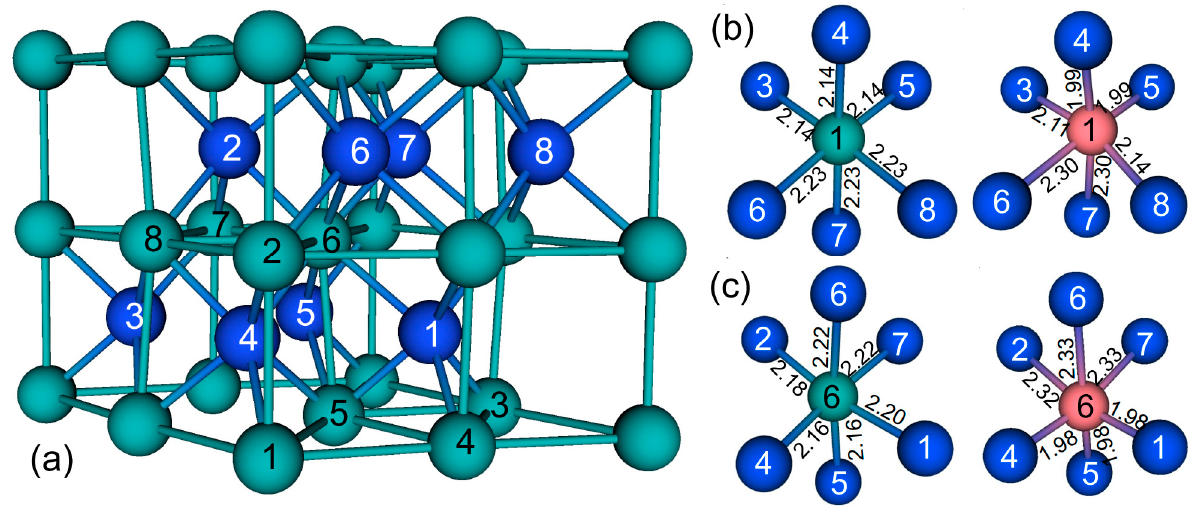
Figure 1. ( a ) Schematic structure of the unit cell of δ -MoN, and optimized bond lengths of ( b ) Mn 1 –N and ( c ) Mn 6 –N in Mn-MoN(2 a ) and Mn-MoN(6 c ), respectively. For comparison, the relaxed bond lengths of Mo 1 –N and Mo 6 –N in the pure δ -MoN are also presented in ( b , c ), respectively. The pink, green, and blue balls denote the Mn, Mo, and N atoms, respectively.